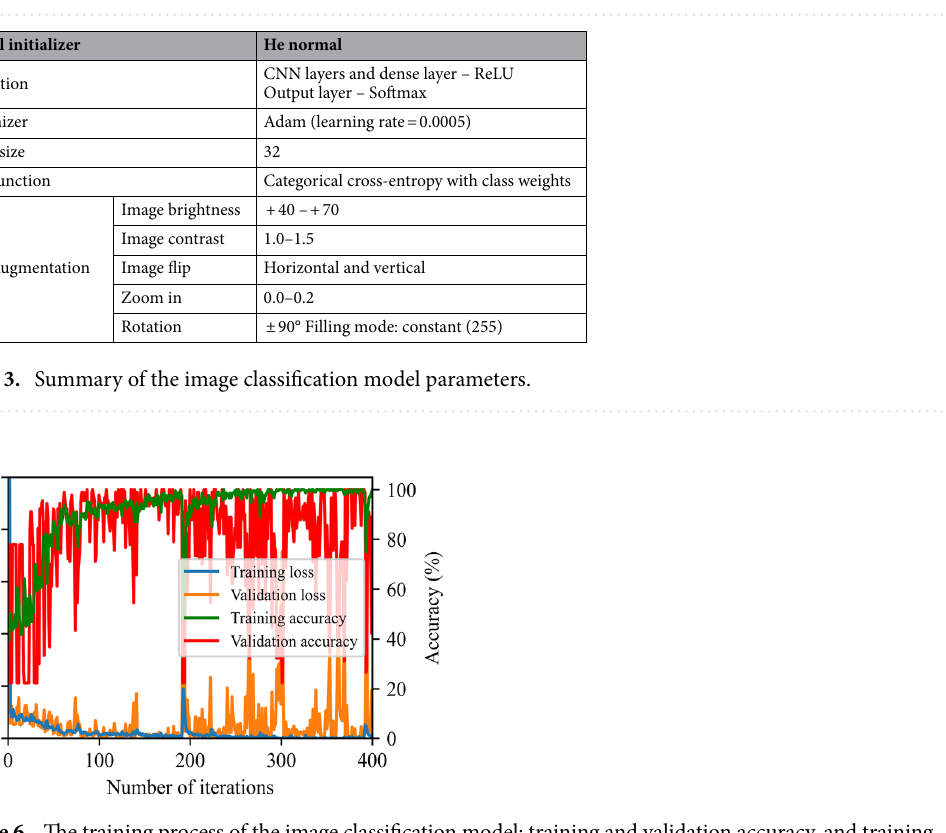
Figure 5. DNN model for image classification: VGG-16 like structure with skip connections.